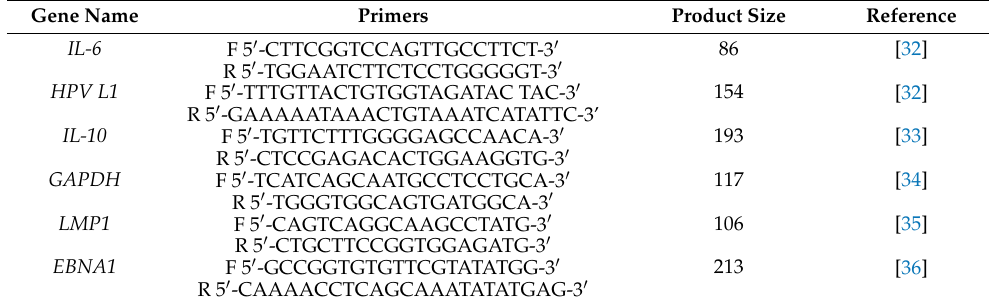
Table 1. The primers and product